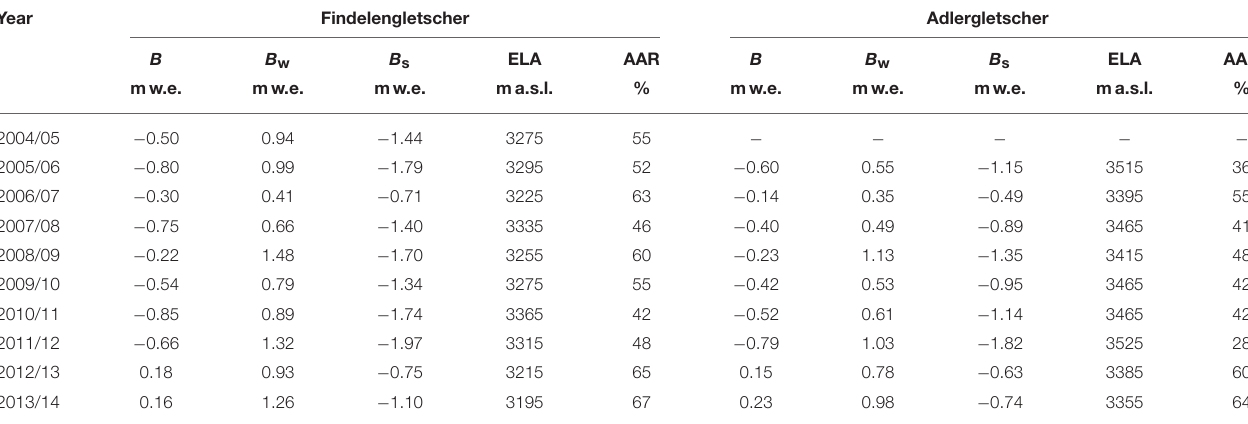
TABLE 4 | Annual ( B ), winter ( B w ) and summer ( B s ) surface mass balance, equilibrium line altitude (ELA), and accumulation area ratio (AAR) of Findelengletscher and Adlergletscher derived by model-based extrapolation of seasonal observations in 2005 to 2014. Year Findelengletscher